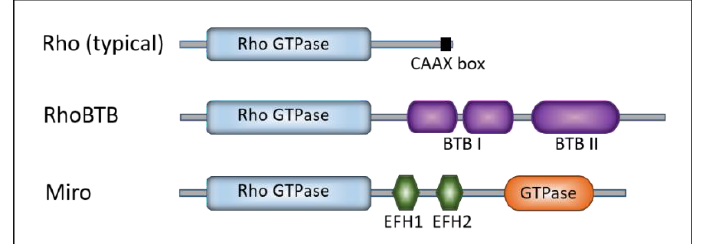
Figure 1. Schematic representation of Rho GTPases. Colored boxes represent characteristic structures: the Rho GTPase domain (light blue), CAAX box (black), BTB (broad complex/tramtrack/bric-a-brac) domain I and II (violet), EFH (EF-hand calcium binding) domain 1 and 2 (green), and the second GTPase domain in Miro (orange).